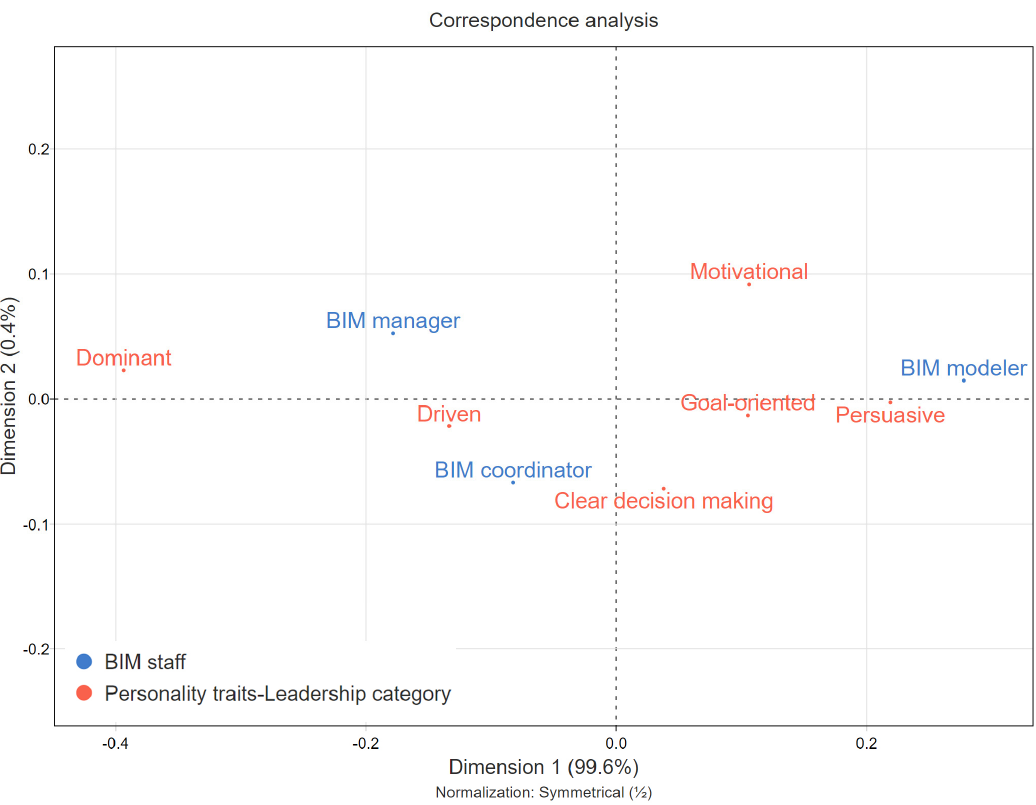
Figure 2. Comparison of the importance degree of personality traits (leadership category) between BIM staff roles—Correspondence analysis.